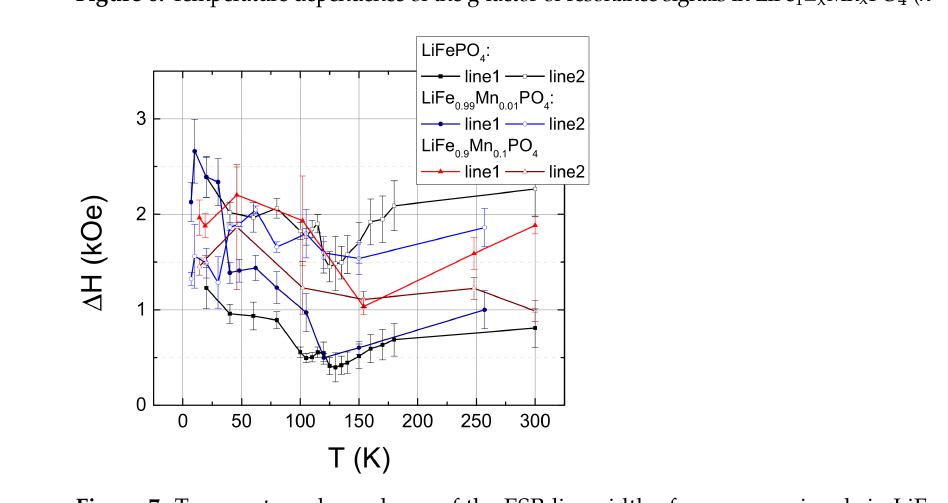
Figure 7. Temperature dependence of the ESR linewidth of resonance signals in LiFe 1 − x Mn x PO 4 (x = 0, 0.01, 0.1).